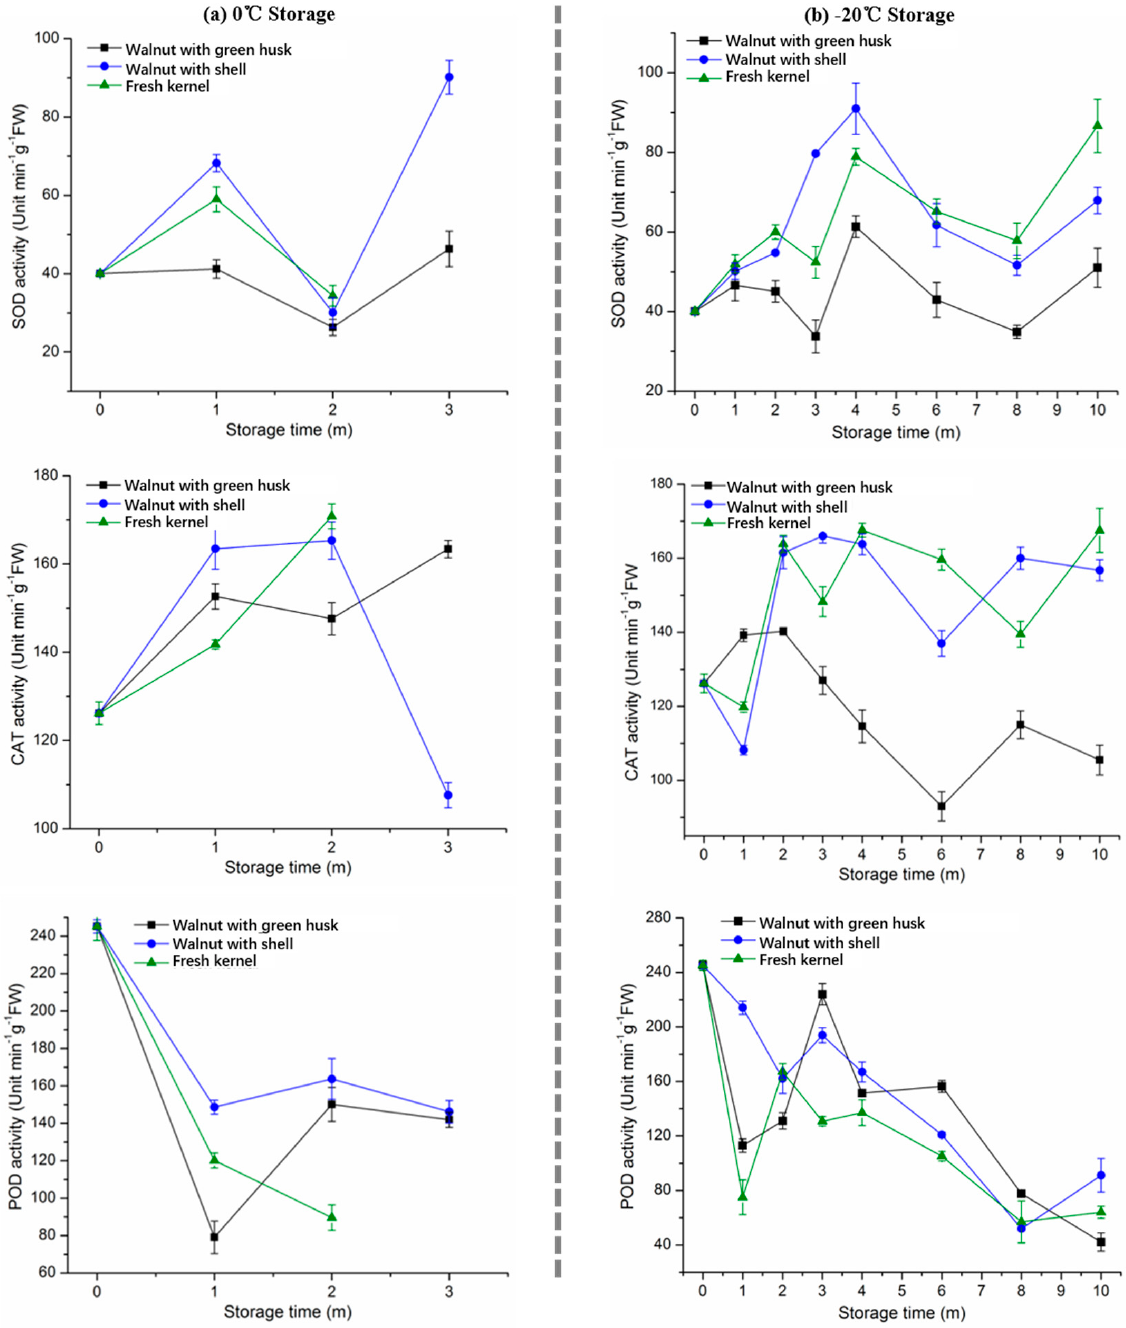
Figure 3. SOD, CAT, and POD activity of walnut kernel under different storage conditions: ( a ) 0 ◦ C and ( b ) − 20 ◦ C. Note: m means month in the figure.